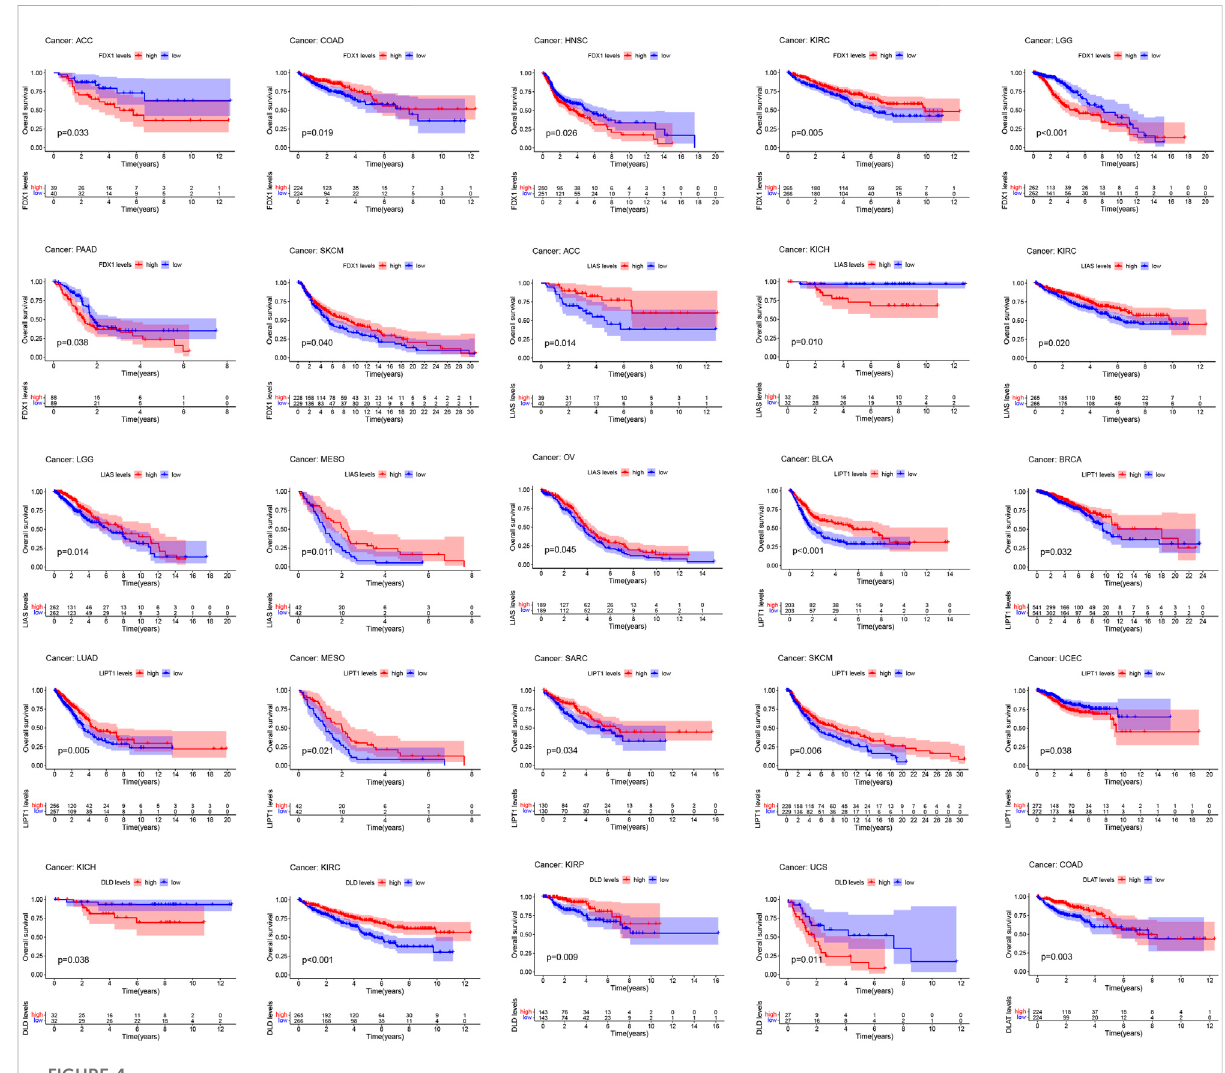
FIGURE 4 Survival analysis of cuproptosis-associated genes in various cancers. The red and blue lines of the picture indicate high and low level, respectively.